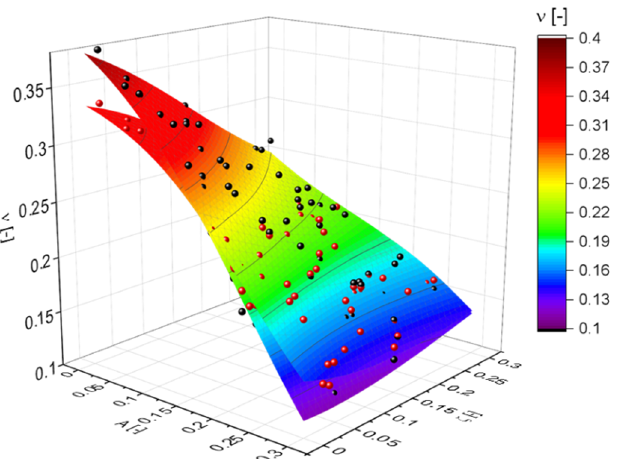
Figure 8. Visualization of the simulation results for the macroscopic Poisson’s ratio. Black and red spheres represent data for ligament shapes G 21 and G 33 , respectively. MLP regressions of both data sets are shown as contour plots.